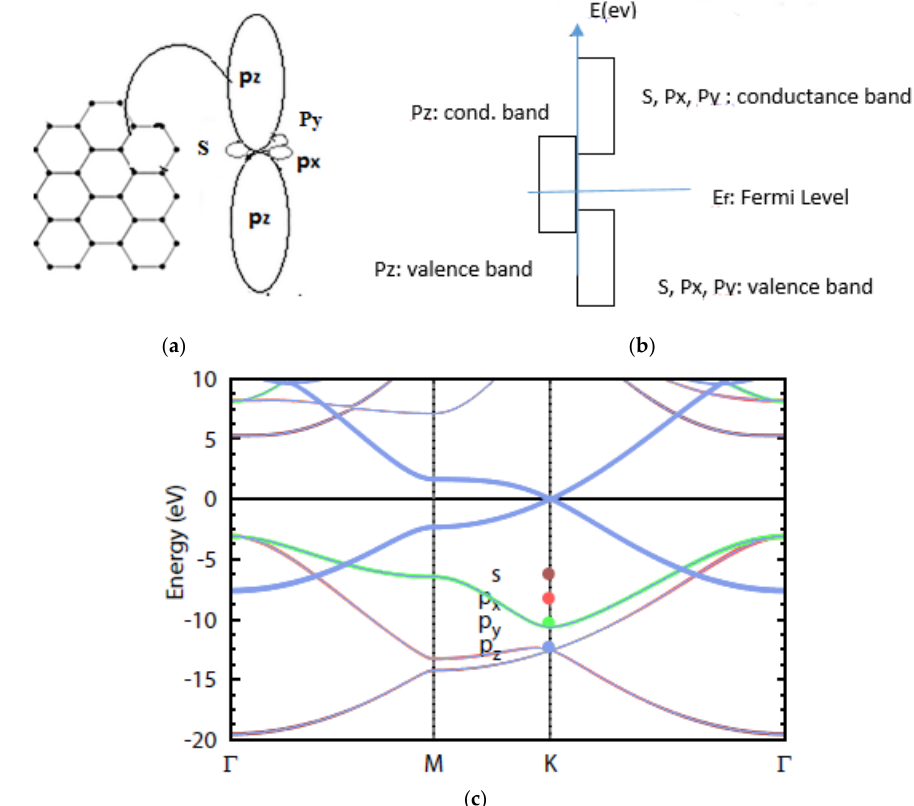
Figure A4. Energy dispersion for 2 s , 2 px , 2 py , and 2 pz . ( a ) Different orbits of graphene; ( b ) valence and conductance band; ( c ) energy dispersion of different orbits of graphene. Additionally, for the three nearest neighbors, the dispersion energy is shown in Fig- ure A5.